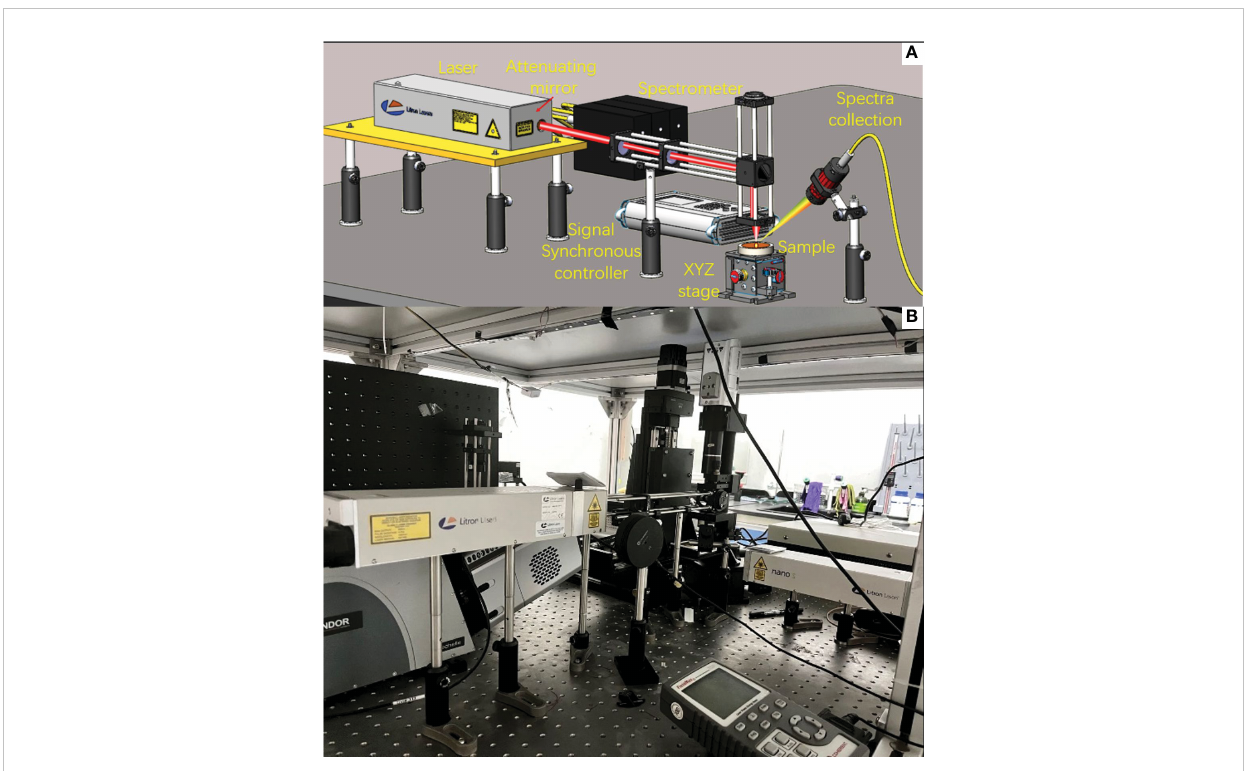
FIGURE 1 The experimental setup of laser-induced breakdown spectroscopy: (A) the schematic diagram of experimental setup; (B) the inside components of the LIBS